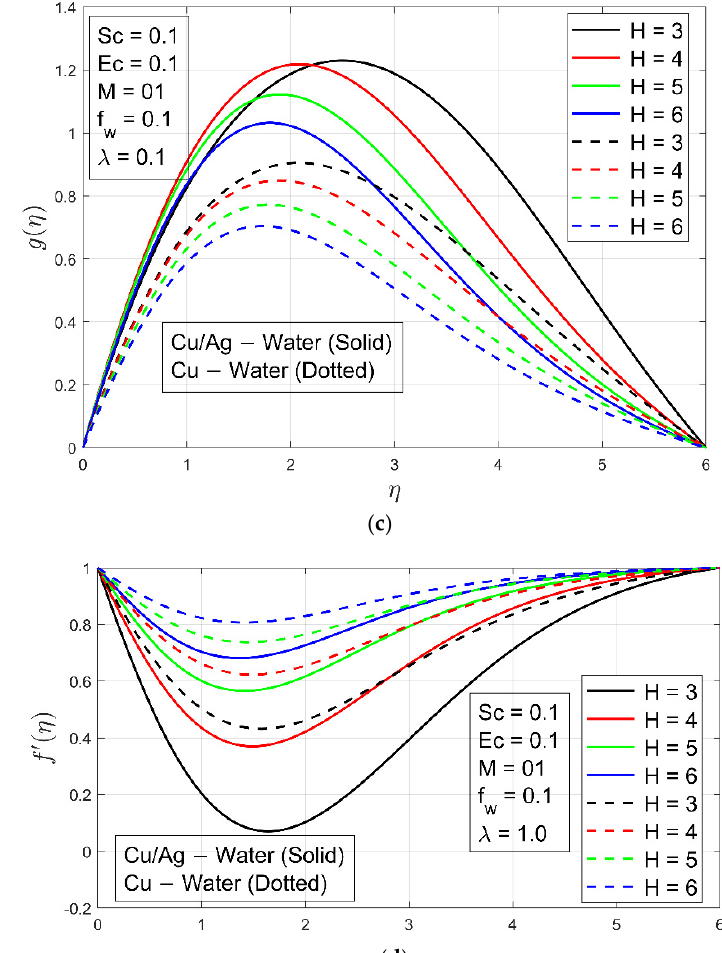
Figure 4. ( a ) Impact of 𝛾 on velocity profile 𝑓 (cid:4593) ( 𝜂 ) . ( b ) Impact of 𝛾 on velocity profile 𝑔 ( 𝜂 ) . ( c ) Impact of 𝐻 on velocity profile 𝑔 ( 𝜂 ) . ( d ) Impact of 𝐻 on velocity profile.